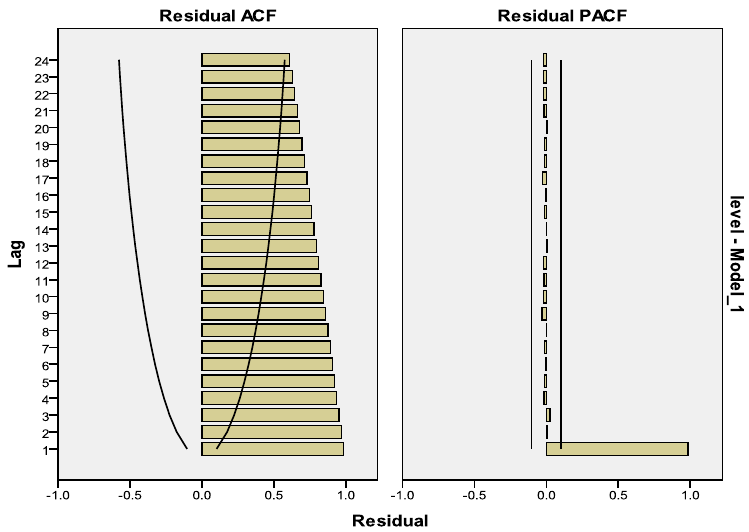
Figure 9. Correlogram of ACF and PACF in case of ARIMA(0,0,0) analysis of CT4 station.